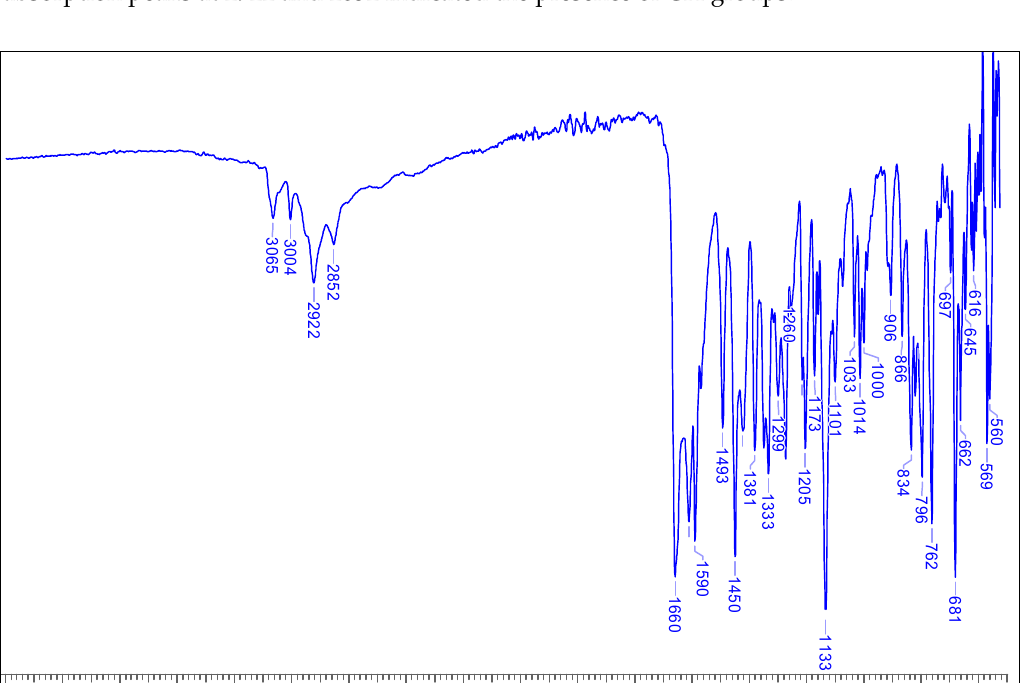
Figure 1. FT-IR spectrum of 6-methyltectochyrin.